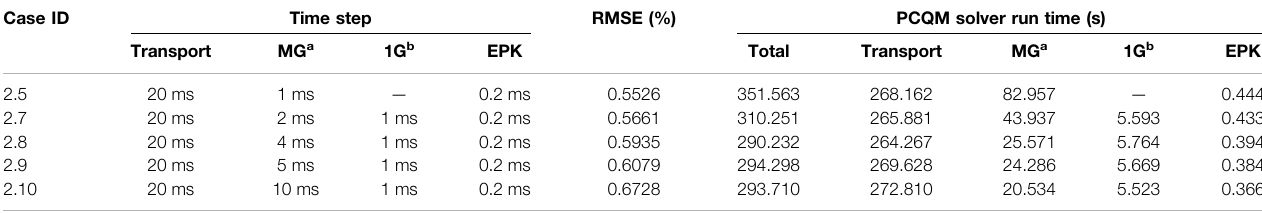
TABLE 4 | Results of accuracy and ef fi ciency for the AML-PCQM cases in Problem 2 Case